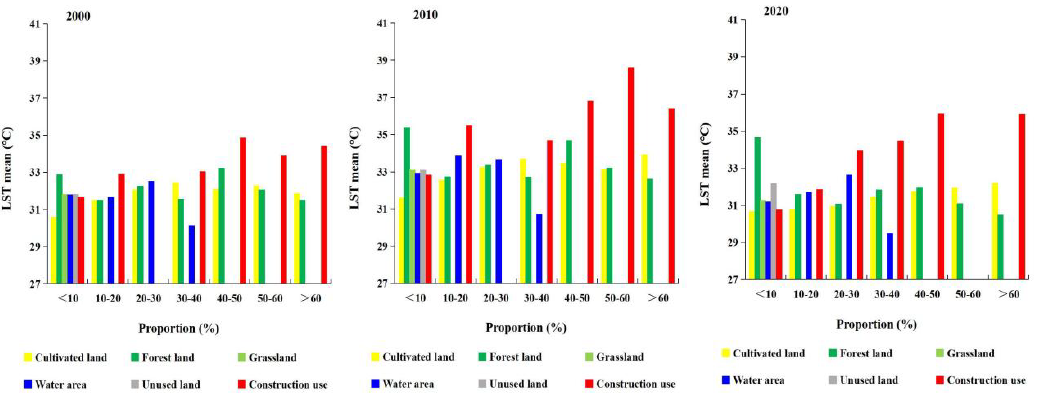
Figure 9. Average LST values of different proportions of land use types in the consecutive period from 2000 to 2020 (represented by the starting year 2000, the middle year 2010, and the end year 2020).